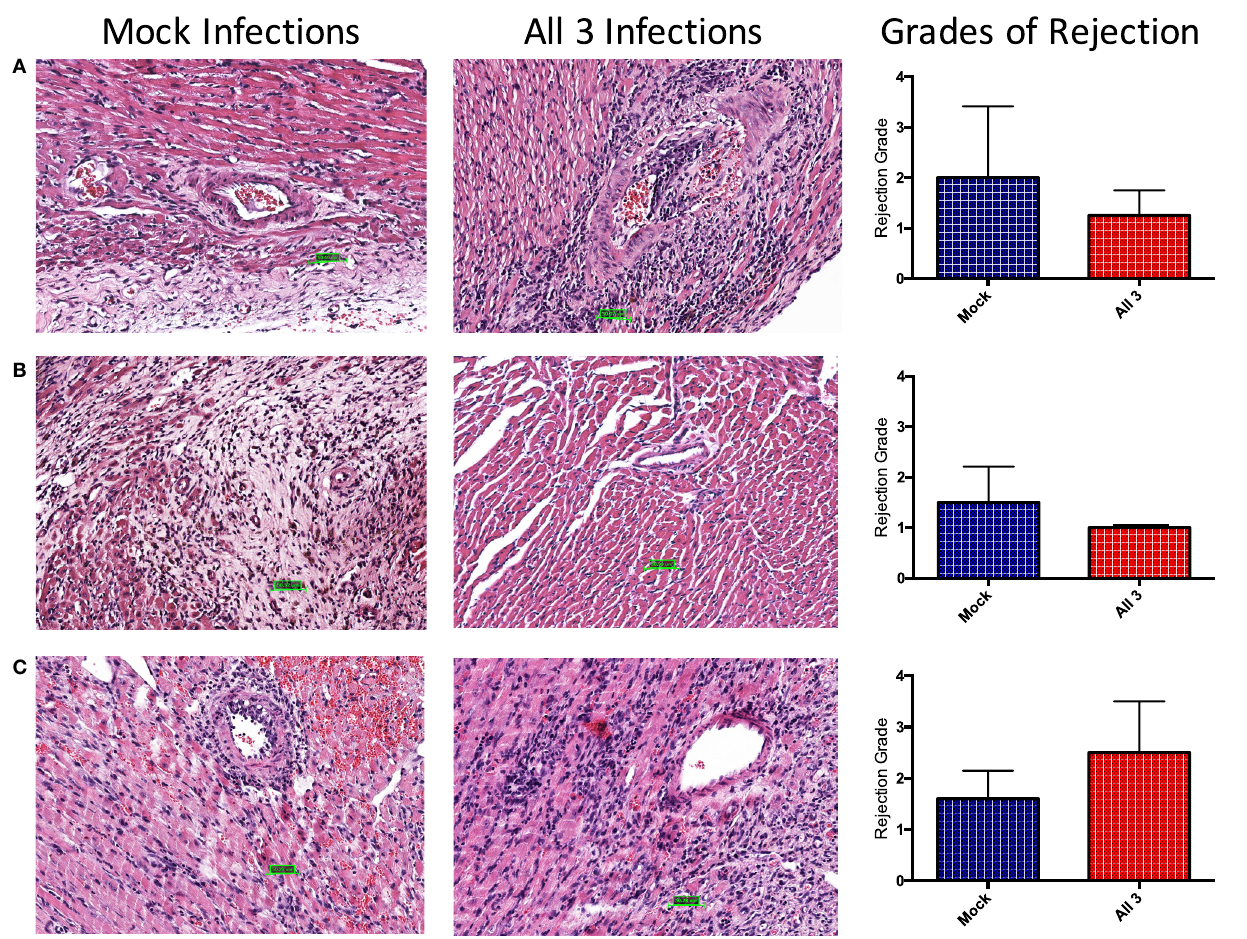
FigUre 8 | No difference in grades of rejection between mock-infected mice and mice that received all three infections. Donor Balb/c hearts were excised from C57BL/6 recipients at the time of sacrifice. H&E staining was performed, and slides were sent to a cardiac pathologist for blinded analysis. Grades of rejection were scored using the ISHLT-2004 acute cellular rejection grading scheme. A score of 0 indicates no rejection, 1 indicates mild rejection, 2 indicates moderate rejection, and 3 indicates severe rejection. (a) Representative histology slides from mock-infected mice with PBS or infected with all three viruses that received fully mismatched heterotopic heart transplants, treated with chronic CTLA4-Ig. Summary data show no significant difference in grades of rejection between groups at day 80 post-transplant ( p = 0.7333). (B) Representative slides from mock-infected or infected mice treated with chronic CTLA4-Ig and rapamycin. Summary data show no significant difference in grades of rejection between groups at day 75 post-transplant ( p = 3333). (c) Representative slides from mock-infected or infected mice treated with CTLA4-Ig on days 0, 2, 4, and 7. Summary data show no significant difference in grades of rejection between groups at day 14 post-transplant ( p = 0.2381). Statistical analysis of grades of rejection between mock-infected and infected mice was performed using nonparametric Mann–Whitney